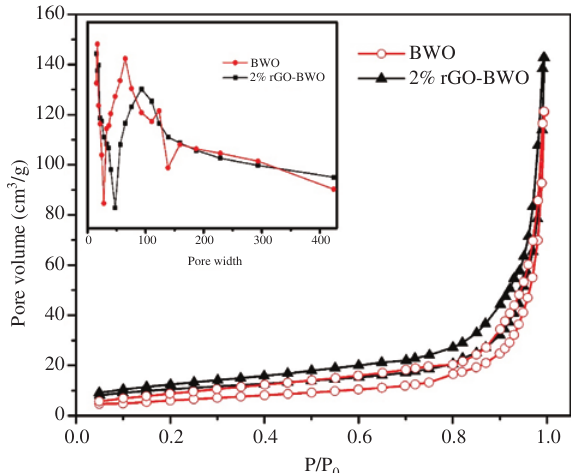
WO , 2% rGO-BWO. 2 6